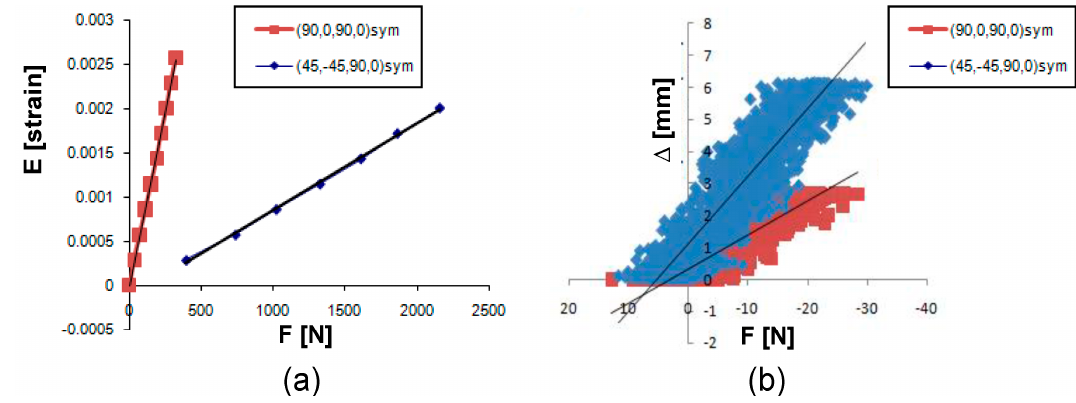
Figure 14. ( a ) Tensile test results; ( b ) bending tests results.